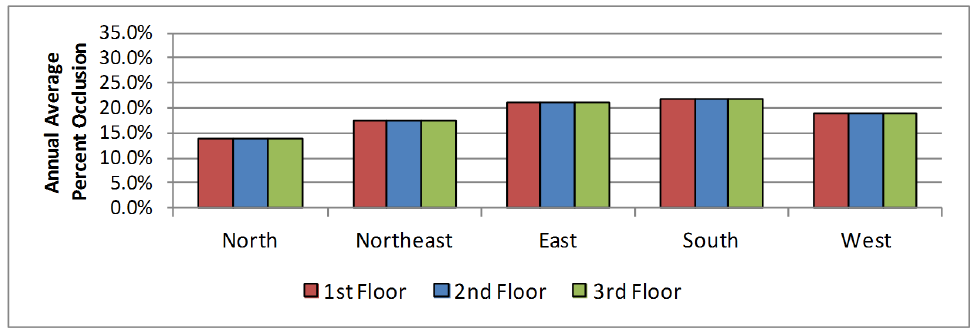
Figure 12. Annual average percent occlusion (Blindswitch